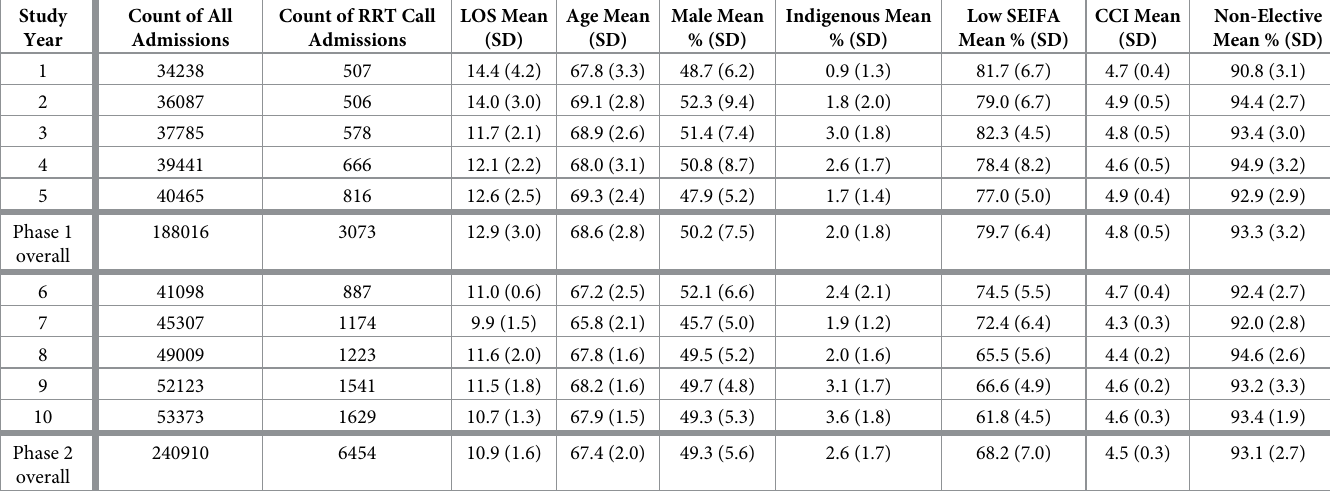
Table 1. Hospital activity and demographic data (for patients having RRT calls) by study year.